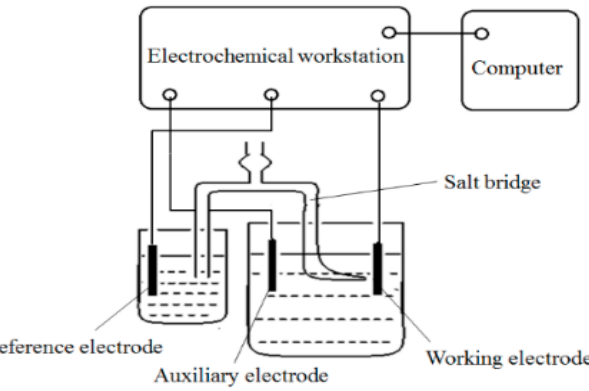
Figure 2. Schematic diagram of the three-electrode system.